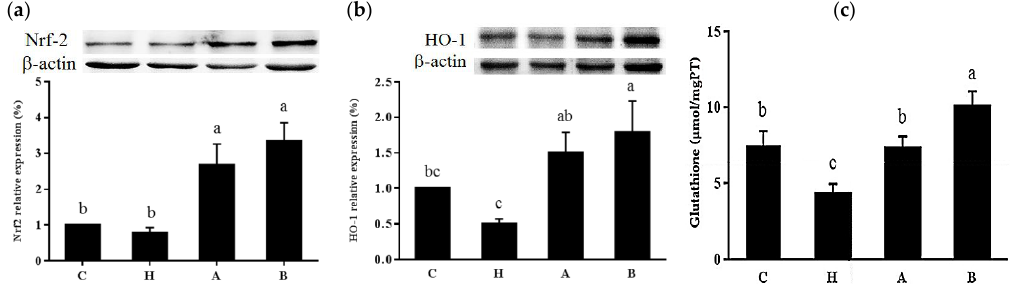
Figure 4. Kidney ( a ) nuclear factor erythroid 2-related factor-2 (Nrf-2), ( b ) cytosolic heme oxygenase (HO)-1 protein expressions, and ( c ) total glutathione (GSH) level in rats. Values are presented as the mean ± SEM ( n = 10). a b c Values with different superscript letters at the end of the study significantly differ ( p < 0.05). C, control group; H, hypertensive group; A, 20 mg/kg/day antroquinonol group; B, 40 mg/kg/day antroquinonol group.